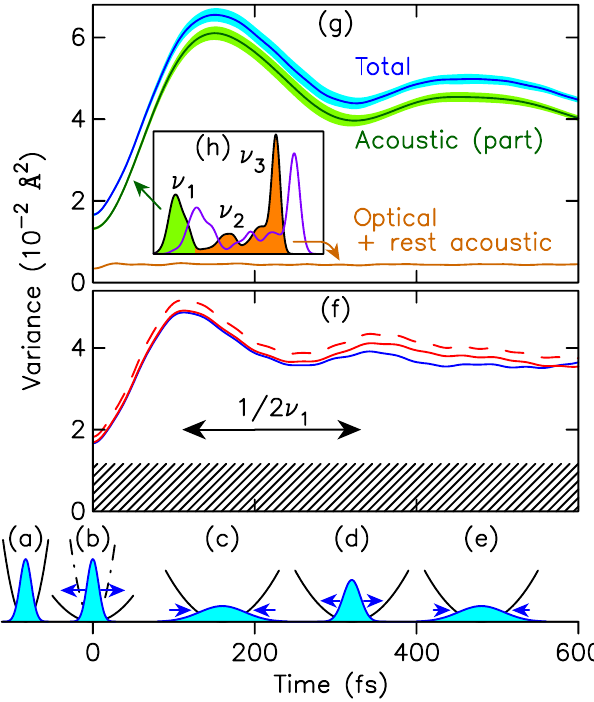
FIG. 2. Time-dependent variance of the atomic displacements at the electronic temperature of 50 mhartree. (a)–(e) Schematic illustration of thermal phonon squeezing. The black curves represent laser-induced changes in the potential. The blue curves represent the distribution of atomic displacements. (f) Ab initio results in the harmonic approximation. The blue curve is for N ¼ 640 . The red curves are for N ¼ 1200 . The solid curves repre- sent classical results. The dashed curve represents the quantum- mechanical result. The hatched region represents the zero-point motion in the laser-excited state. (g) Ab initio molecular- dynamics results: total and spectrally decomposed variances averaged over nine runs ( N ¼ 640 ). The light shaded areas represent standard deviations of the averages. (h) Phonon density of states before (purple curve) and after (black curve and shaded areas) femtosecond-laser excitation in the range from 0 to 17.5